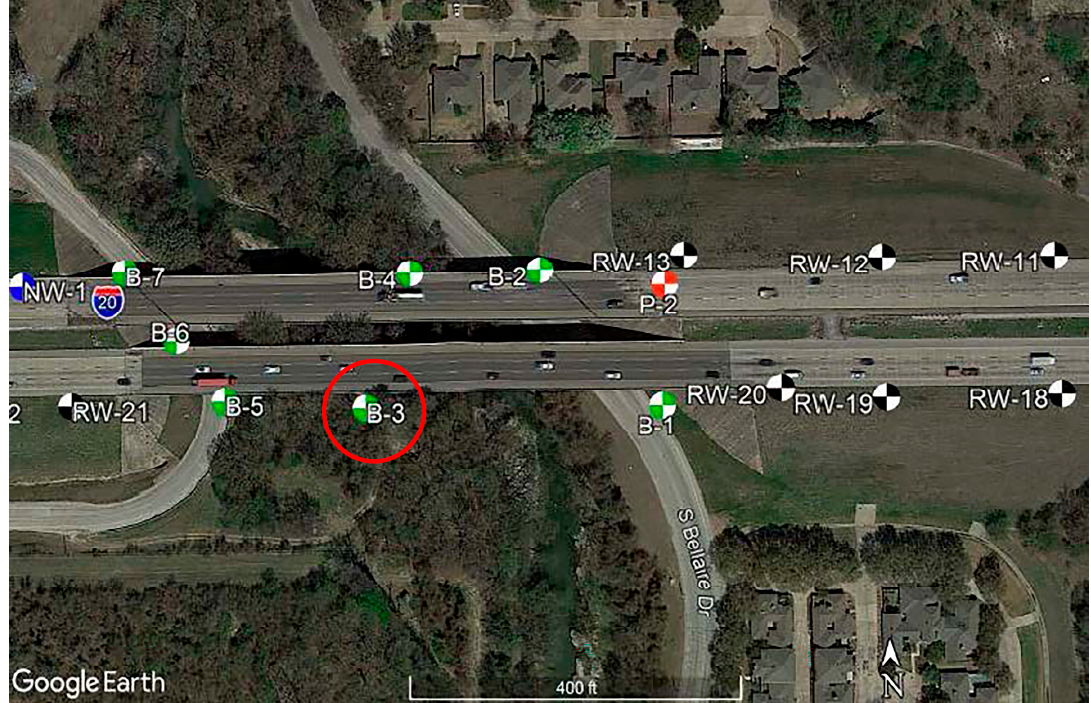
Figure 5. Geotech borehole locations (B-3 is the borehole involved in this study).